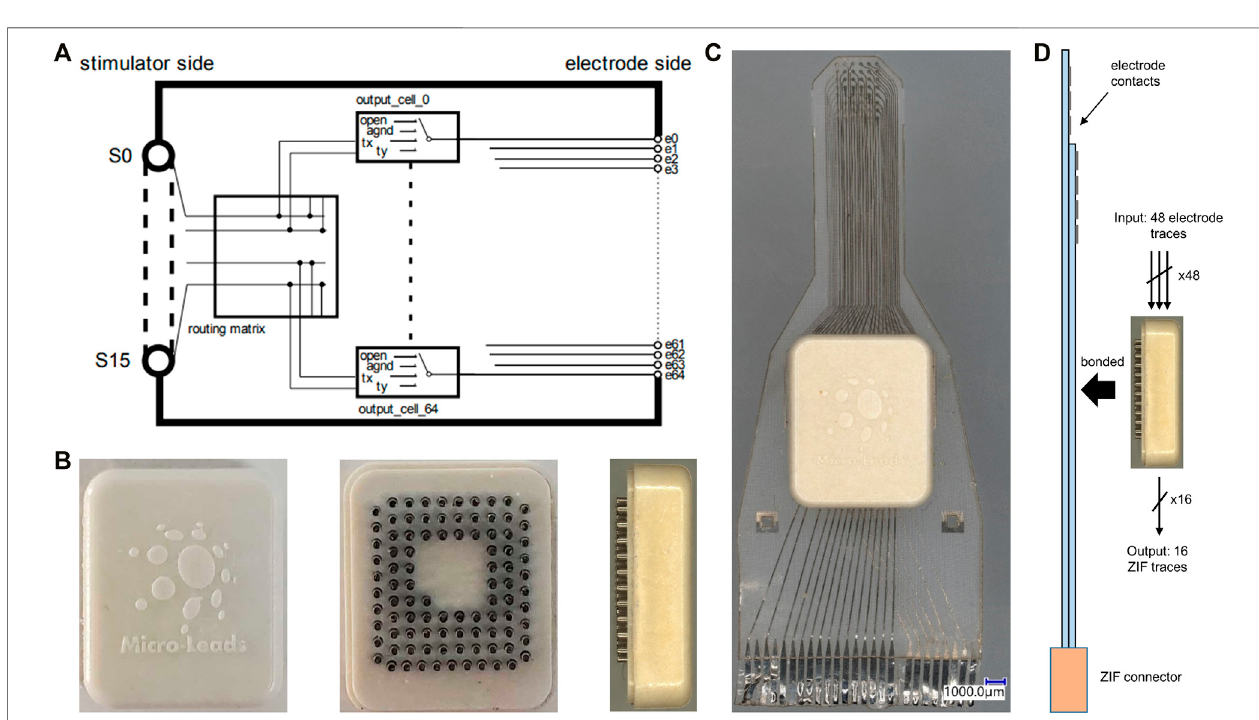
FIGURE2| 1664ASICandactiveelectrodearrayfabrication. (A) SchematicofML1664ASIC.64multiplexersconnecteachelectrodelinetoseveraloutputSlines. (B) The ASIC inside LCP packaging in top, bottom and side view from left to right. Pin-grid feedthroughs are used for thermal bonding to the electrode array substrate. (C) Active electrode array with embedded multiplexing ASIC within an LCP electronics package. The electronics package contained a pin-grid array bonded to the electrode array and under fi lled. The active electrode used two metal layers for wiring, evident from the different shade of traces on left and right side of ZIF connector. (D) Diagram of pin-grid attachment to the active-electrode array using thermal bonding. 48 electrode contacts wire to inputs of 8 × 6:1 MUXs on the 1664 ASIC and 16 outputs connect via ZIF to recording system, thereby reducing output wire count.